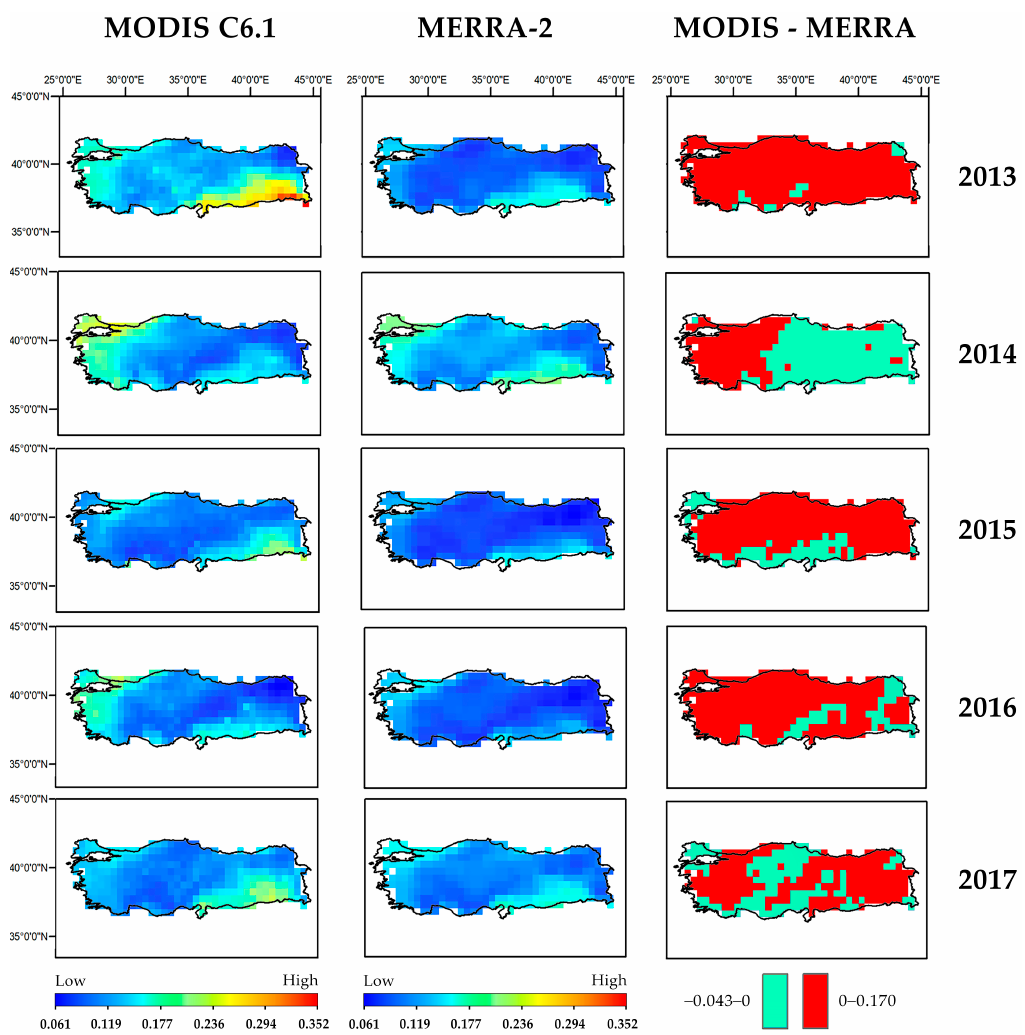
Figure 3. First and second columns present average annual scenes of MODIS Aqua and Terra combined and MERRA-2 AOD over Turkey, according to 50 × 50 km 2 grid cells. MODIS 10 × 10 km 2 and MERRA-2 50 × 62.5 km 2 pixel sizes were converted to a grid of 50 × 50 km 2 to obtain the same spatial resolution when comparing the two datasets. The third column shows the difference in AOD between MODIS and MERRA-2. A positive pixel value indicates that the MODIS annual AOD value is higher than that of MERRA-2, while a negative pixel value indicates the opposite.